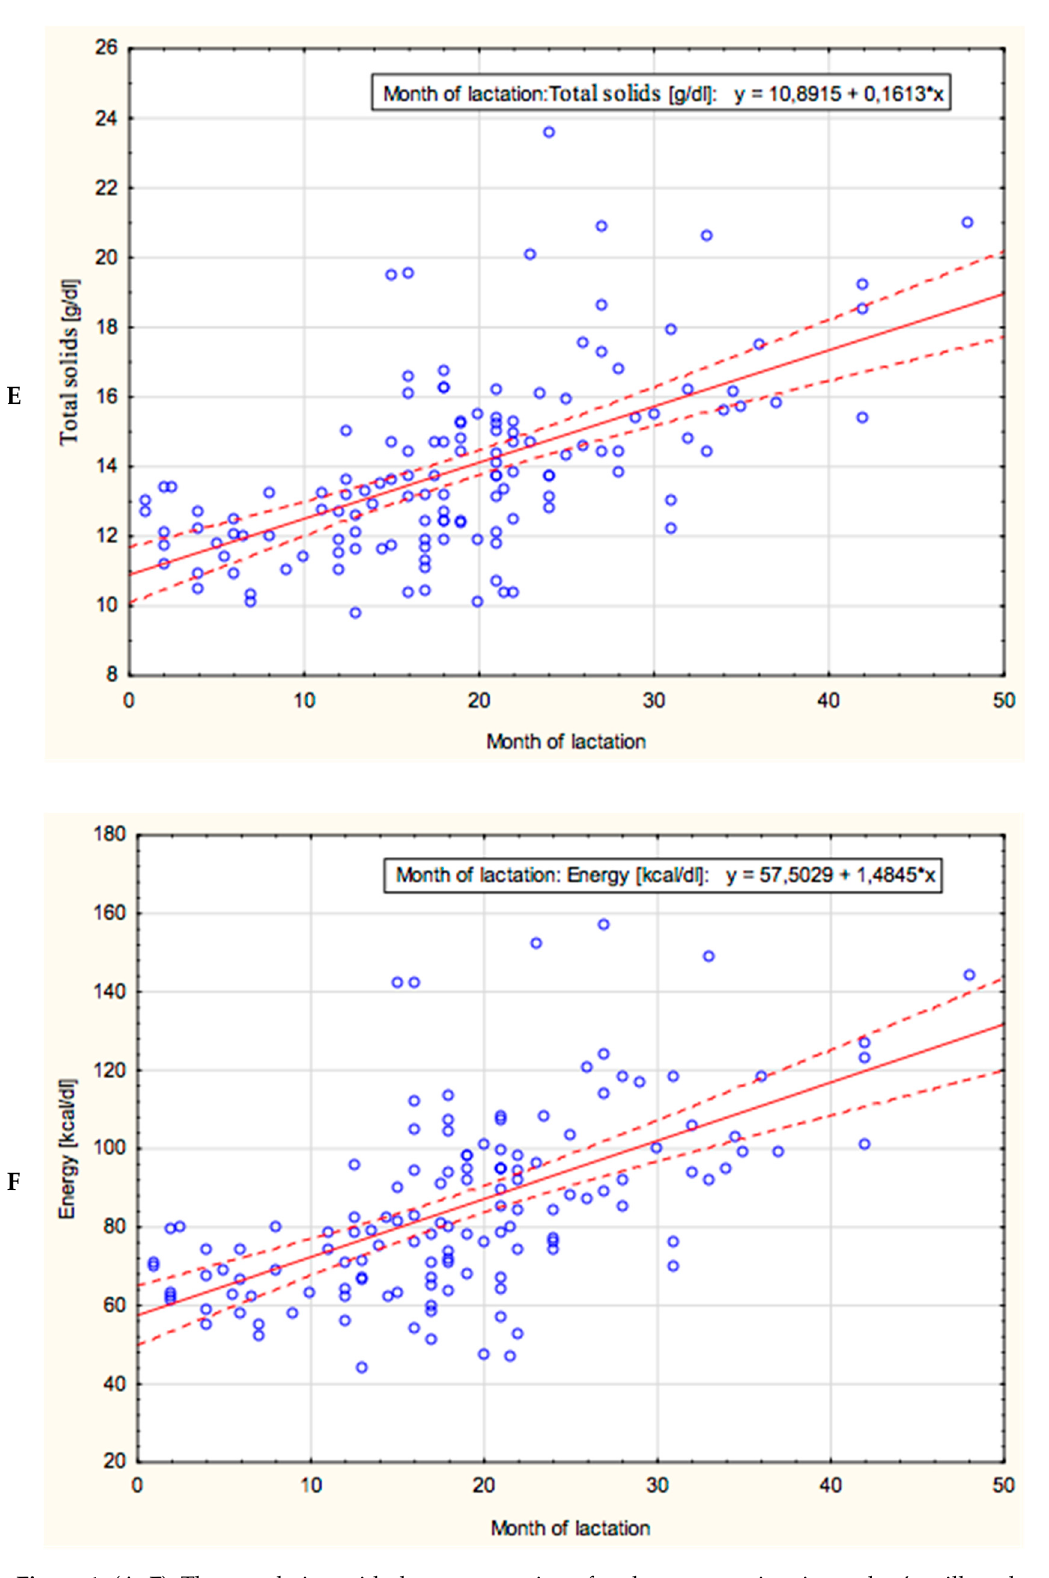
Figure 1. ( A – F ). The correlation with the concentration of each macronutrient in mother’s milk and lactation from the 1st to the 48th month. *: multiplied.